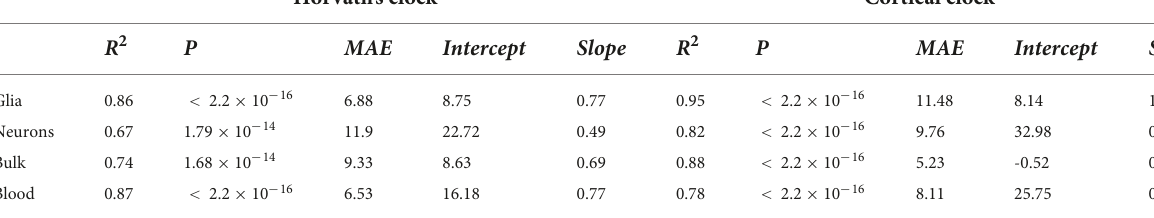
TABLE 2 Characteristics of linear regression of DNAm age estimations from Horvath’s and Cortical clock on chronological